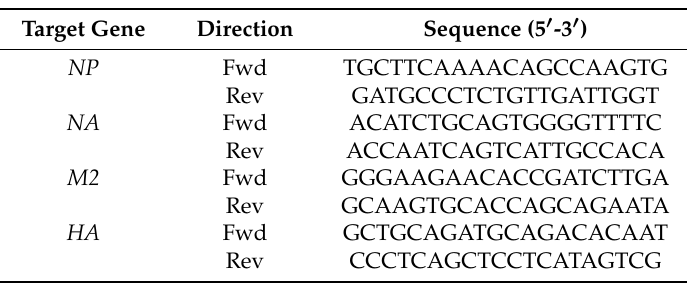
Table 1. Primer sequence for qRT-PCR. Target